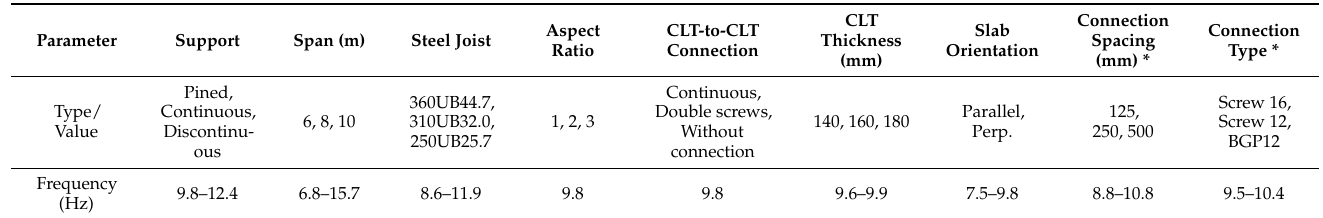
Table 12. Effect of various parameters on STC floor frequency studied numerically by Hassanieh et al.